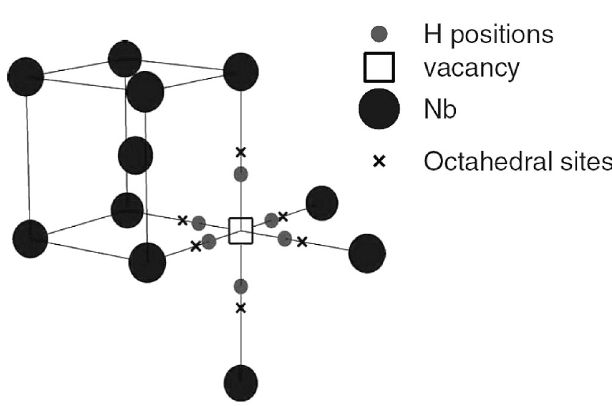
FIG. 13. Six possible lowest-energy sites for a single H atom trapped in Nb vacancy